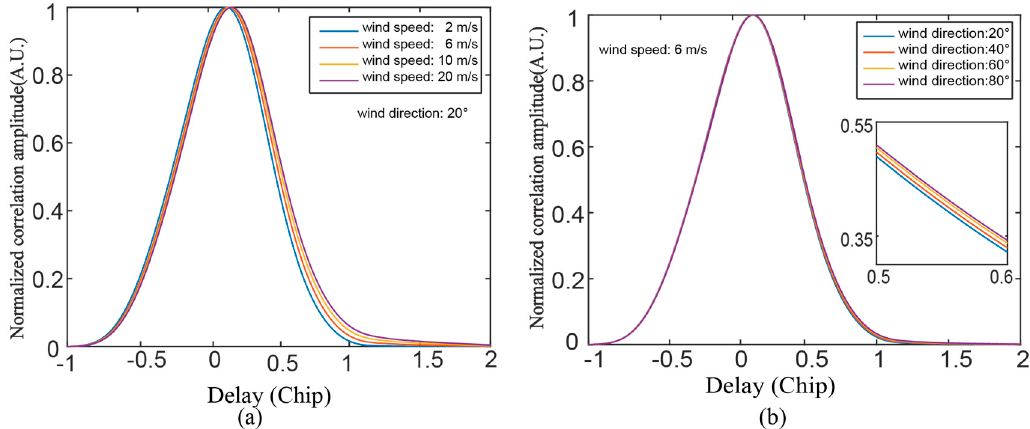
Figure 1. Simulation of the 1-D delay waveform for different wind conditions: ( a ) Wind speed from 2 m/s to 20 m/s, wind direction: 20°. ( b ) Wind directions from 20° to 80°, wind speed: 6 m/s.